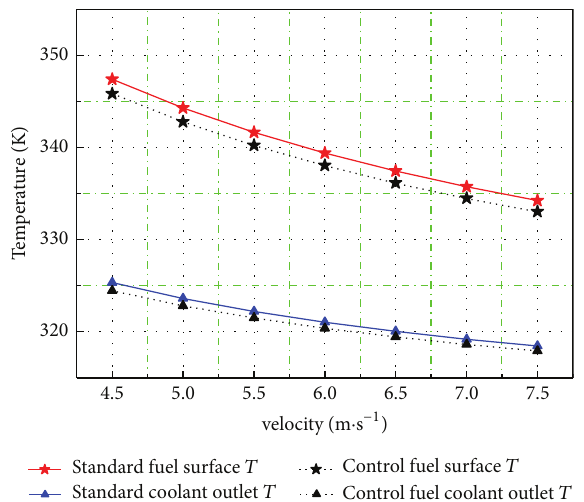
Figure 15: Temperature comparison of fuel surface and outlet coolant between standard and control fuel